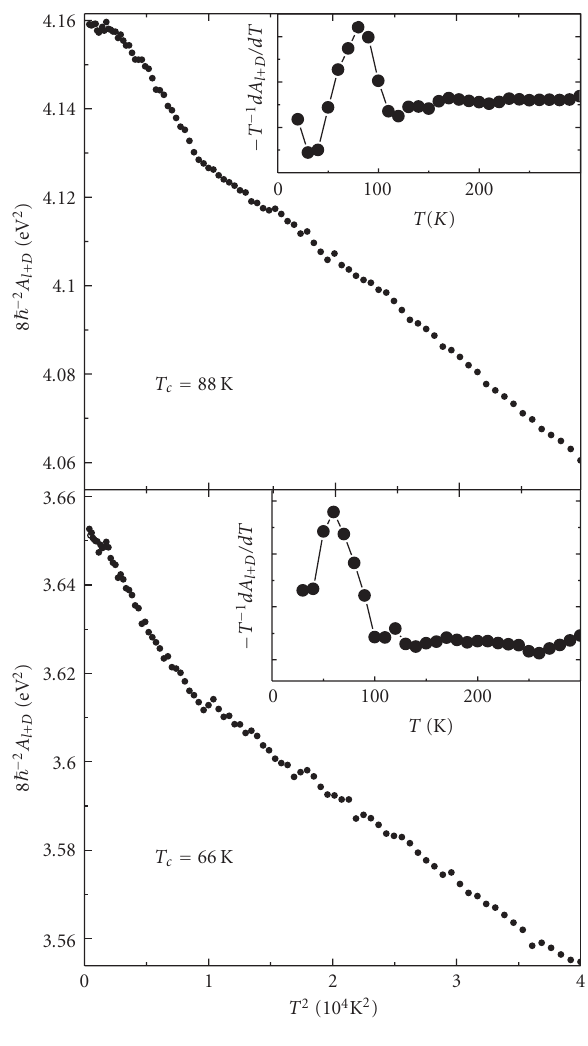
Figure 9: Measured spectral weight W s ( Ω c , T )( ∼ A l + D in figures) for Ω c ≈ 1 . 25eV in two underdoped Bi 2212 (with T c = 88K and T c = 66K). From